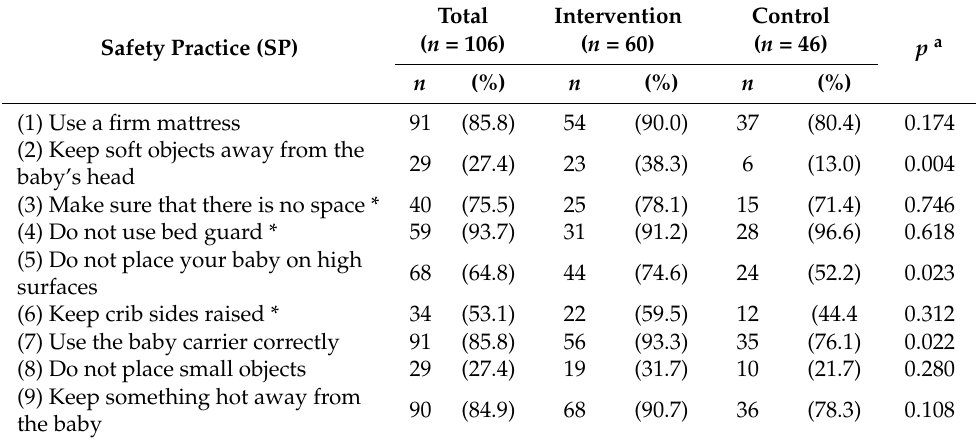
Table 4. Implementation status of participants’ safety practices at T3 (postnatal) ( n =